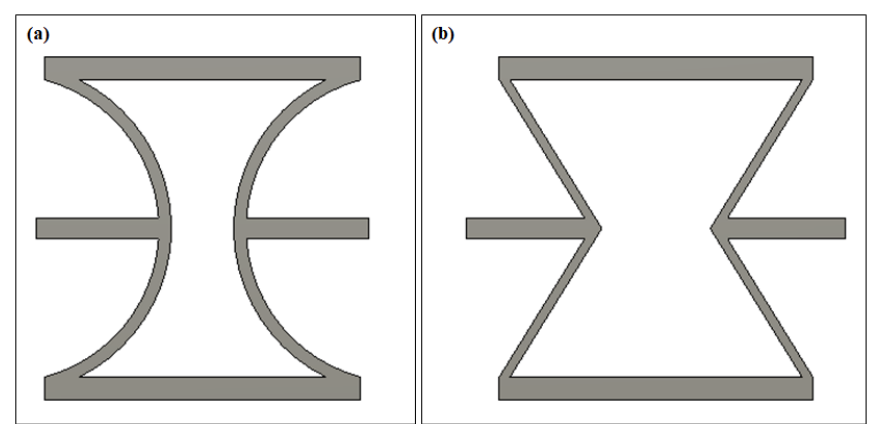
Figure 1. Negative Poisson ′ s ratio metamaterial units ( a ) cylindrical-shell (CS)-based unit and ( b ) re-entrant unit.